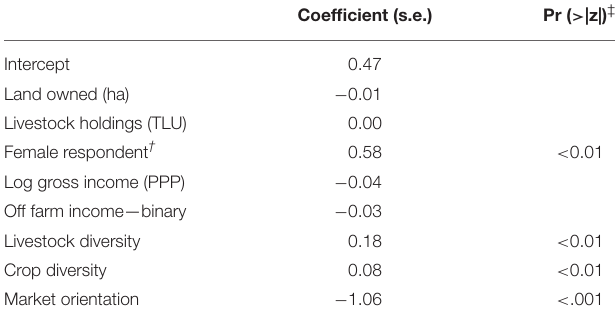
TABLE 6 | Model 1: Binomial regression on female control—Subset of households with respondents in coupled households ( n = 2,454). Coefficient (s.e.)